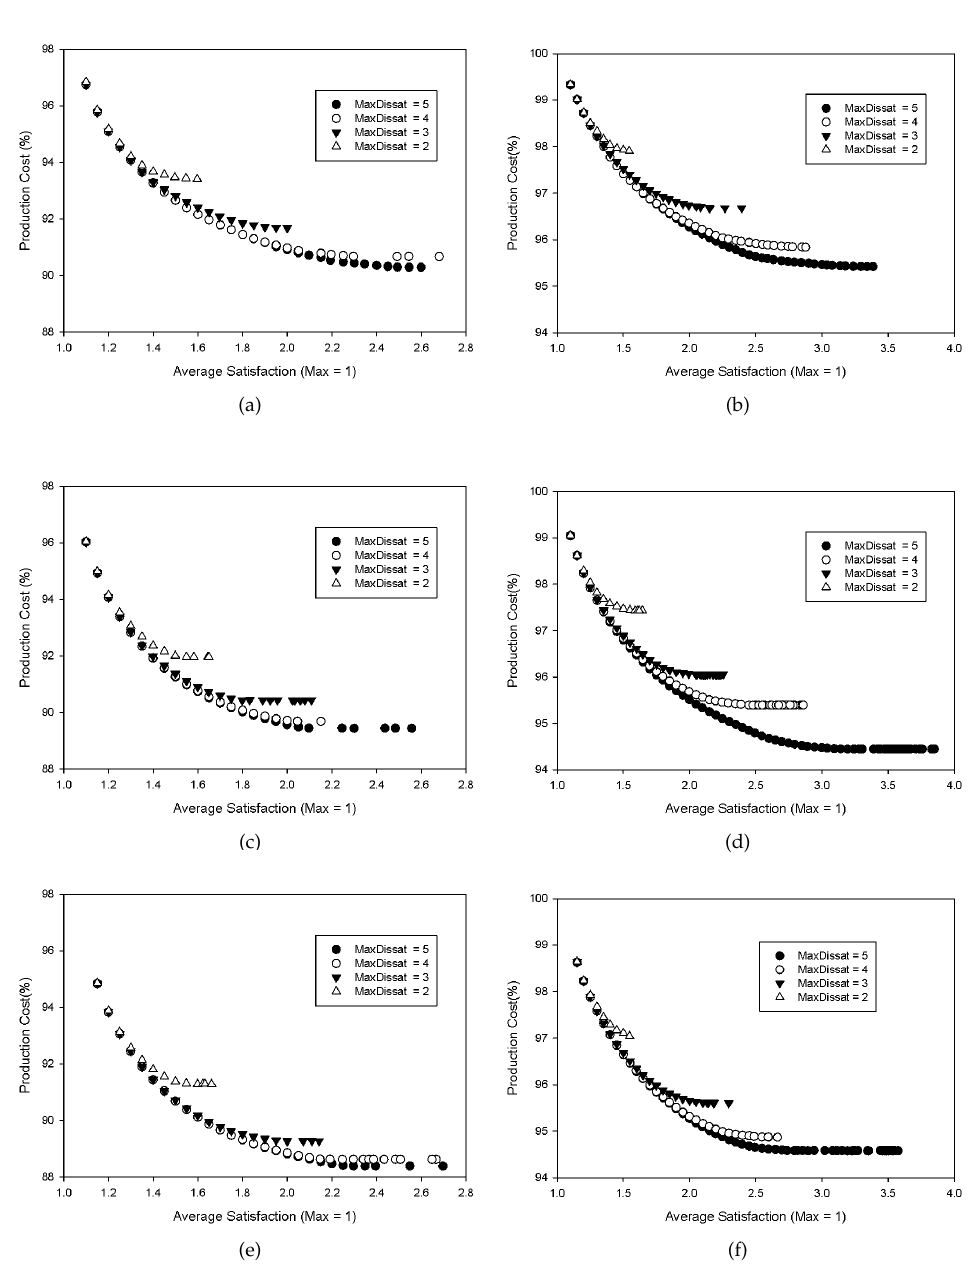
Figure 6. The relation between average comfort levels and productions costs for a different number of households and the maximal allowed dissatisfaction levels. Production cost is defined as a linear approximation of a convex function (left) and using an hourly pricing scheme (right). Comfort levels vary between 1 and 6; Level 1 represents the maximum satisfaction, while Level 6 is the minimum satisfaction. ( a )Pareto fronts (PFs) for 50 households using ProdCost LP ; ( b ) PFs for 50 households using ProdCost HP ; ( c ) PFs for 150 households using ProdCost LP ; ( d ) PFs for 150 households using ProdCost HP ; ( e ) PFs for 250 households using ProdCost LP ; ( f ) PFs for 250 households using ProdCost HP